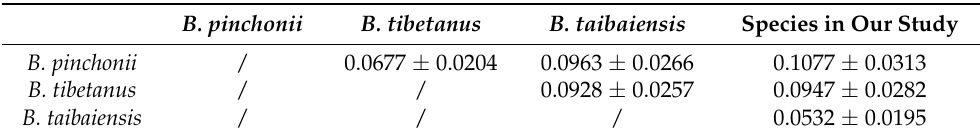
Table 3. The interspecies genetic distances of Batrachuperus .